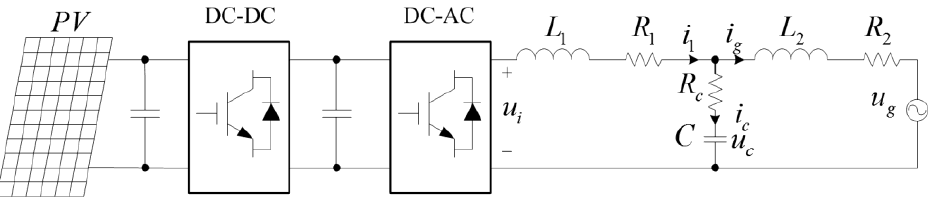
Figure 1. Two-stage single-phase grid-connected PV system with LCL filter typical topology.